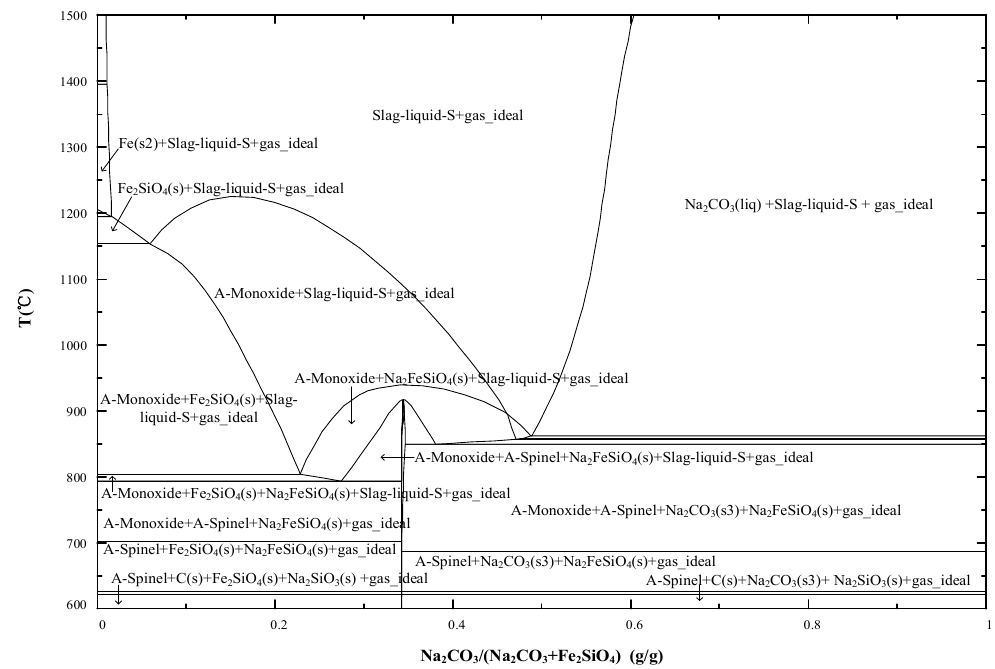
Figure 8. Binary phase diagram of Fe 2 SiO 4 –Na 2 CO 3 (The simulation is carried out at 1 atm).